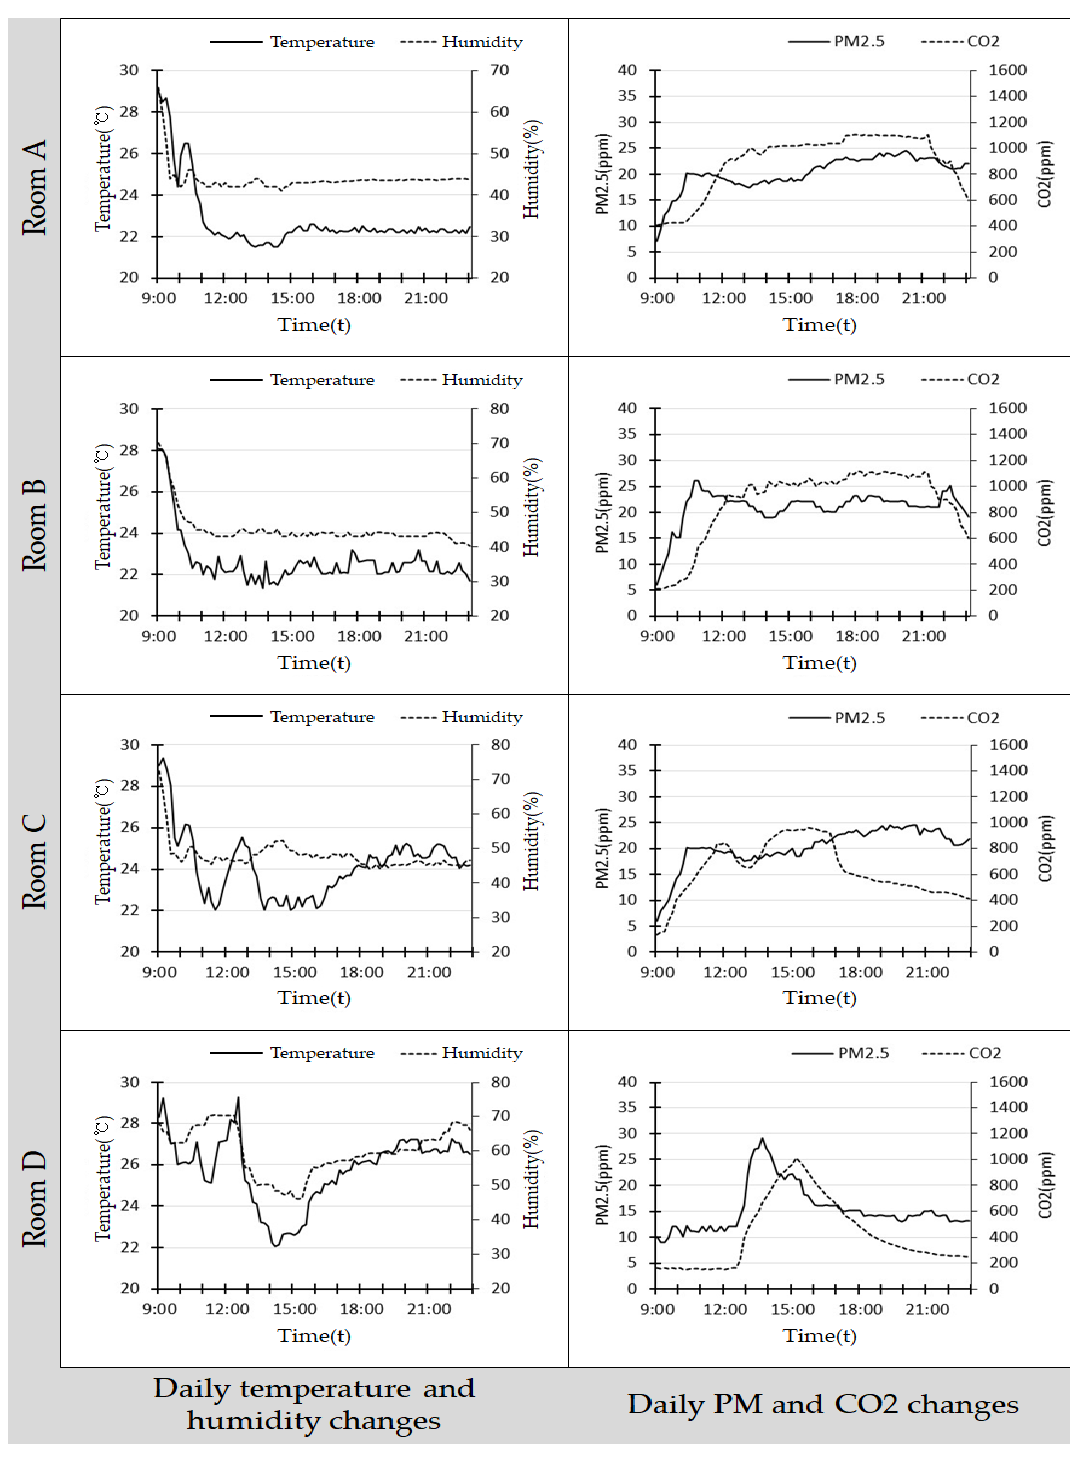
Figure 6. Analysis of daily indoor environment for each room.